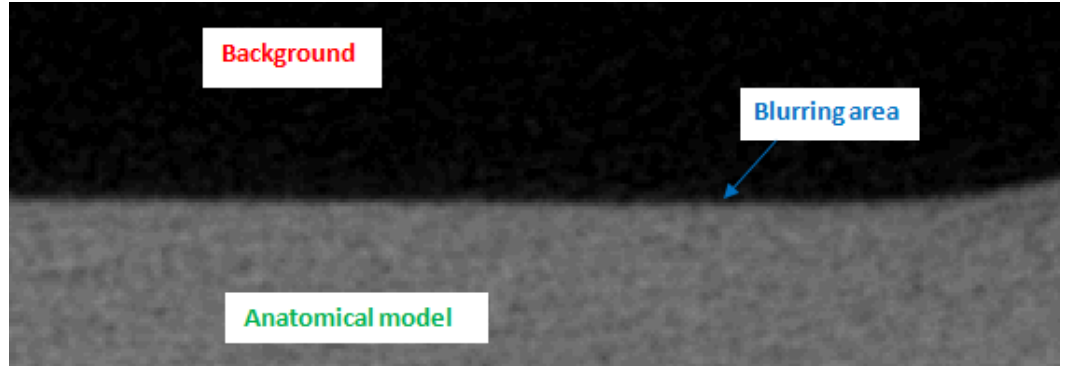
Figure 8. A part of the tomography image with specified areas for the Precimid 1170